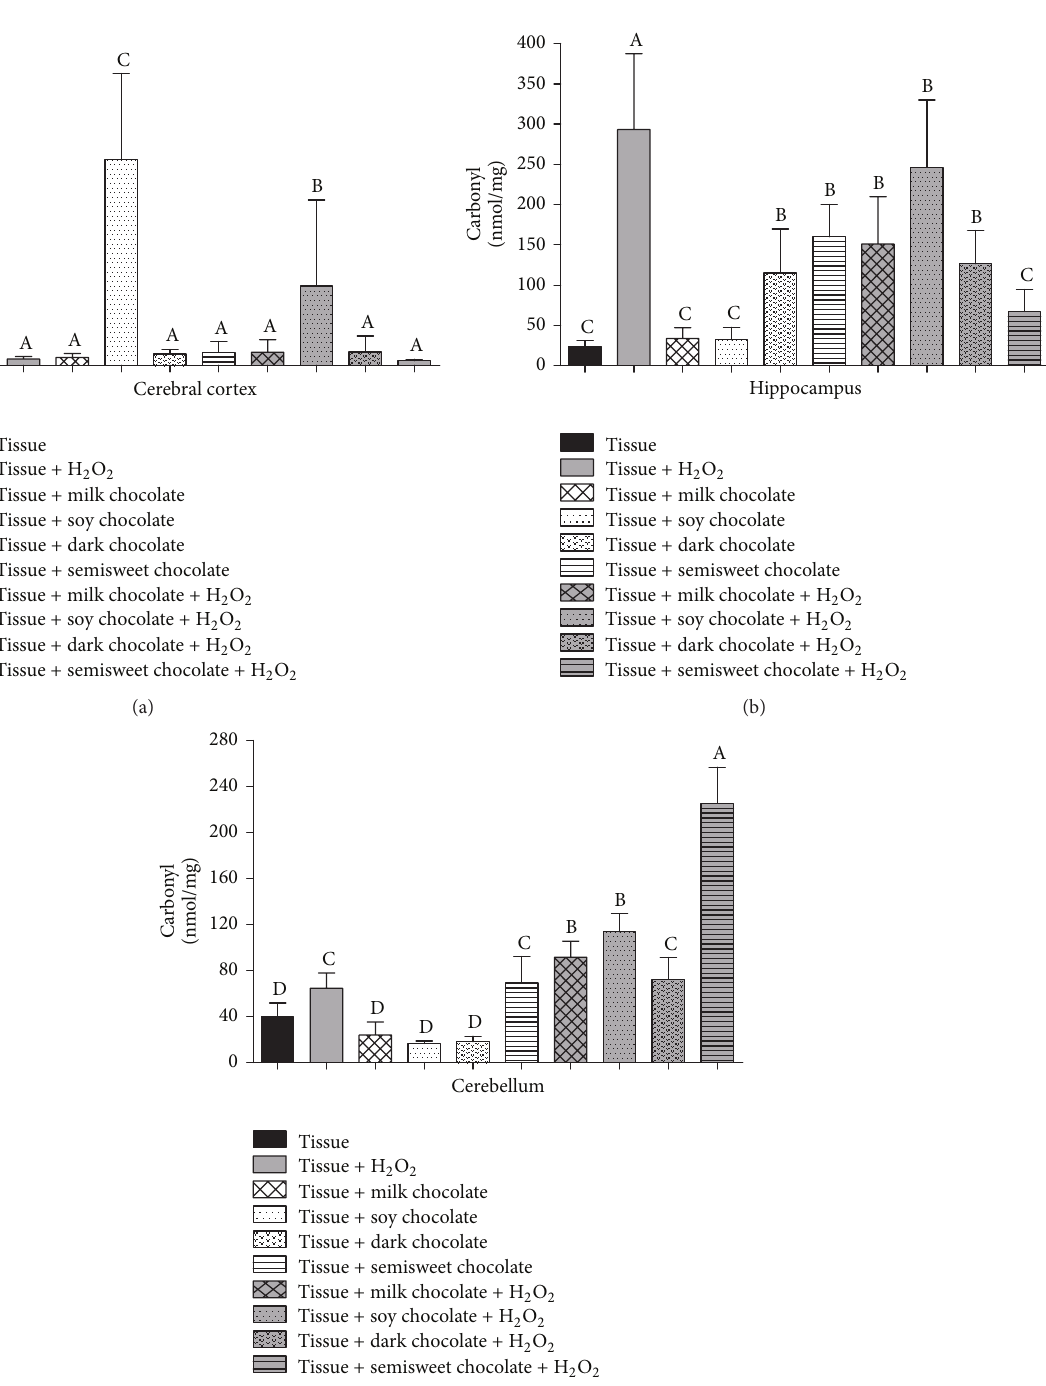
isoflavones (genistein and daidzein); these have high antioxi- dant power requiring less quantity to have a good antioxidant potential